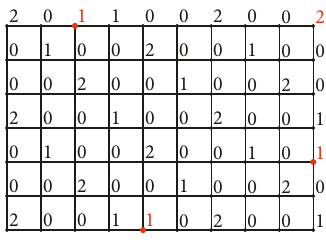
Figure 7: The function f ′ where r � 3 k + 1 , s � 3 l + 1 and r ≡ 4